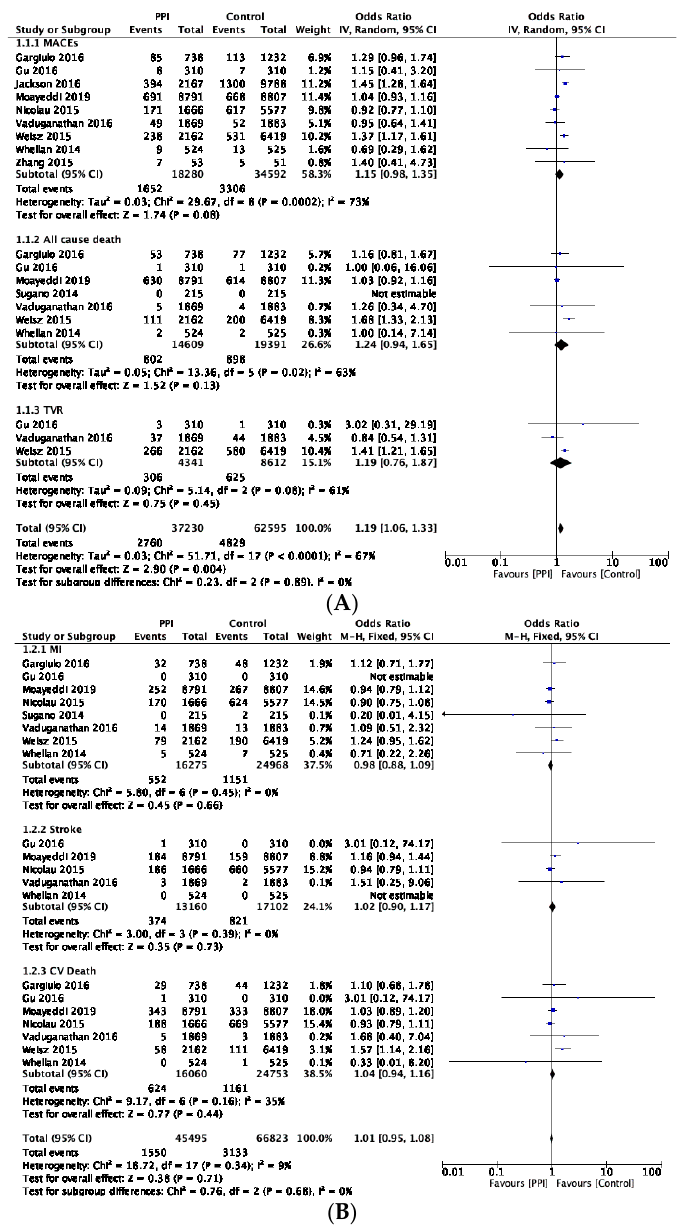
Figure 3. ( A ) Forest plot illustrating the cardiovascular risk associated with long ‐ term PPI use using a random ‐ effects model. ( B ) Forest plot illustrating the cardiovascular risk associated with long ‐ term PPI use using a fixed ‐ effects model. Zhang 2015 [9]; Gu 2016 [14]; Nicolau 2015 [15]; Gargiulo 2016 [16]; Moayeddi 2019 [17]; Sugano 2014 [18]; Vaduganathan 2016 [19]; Whellan 2014 [23]; Jackson 2016 [20]; Weisz 2015